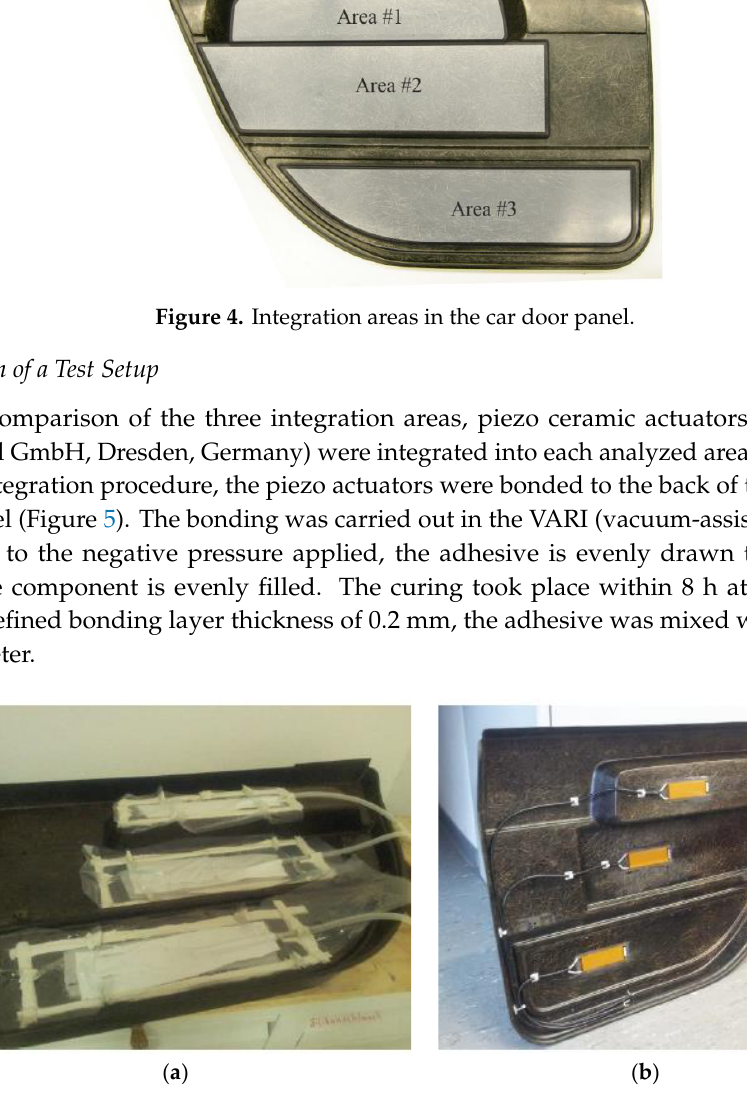
Figure 5. ( a ) Production setup of the secondary bonding process, and ( b ) finished component.